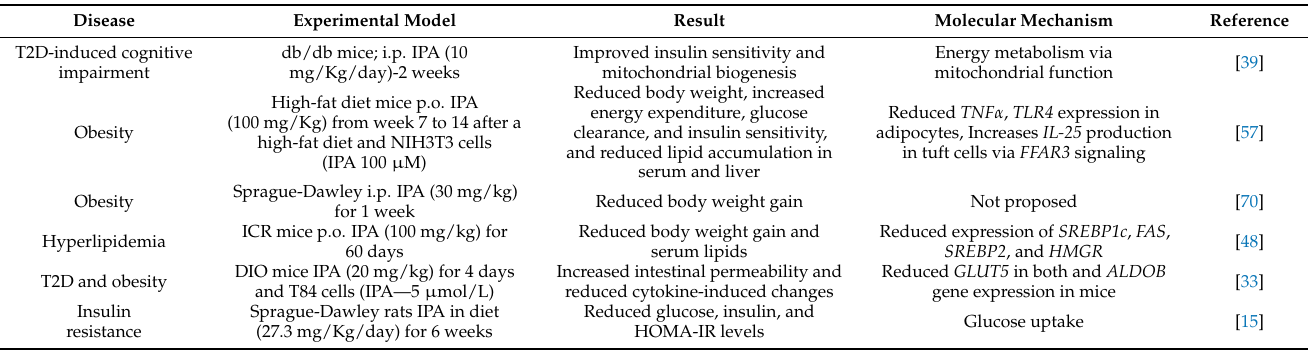
Table 1. Beneficial effects of indolepropionic acid in type 2 diabetes and associated